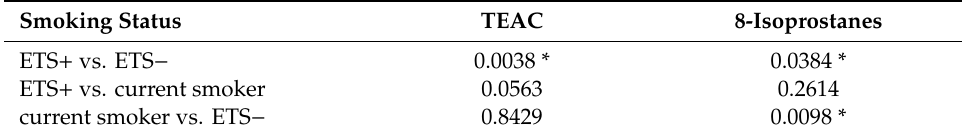
Table 5. Statistical significance ( p -value) of TEAC and levels of 8-isoprostanes.